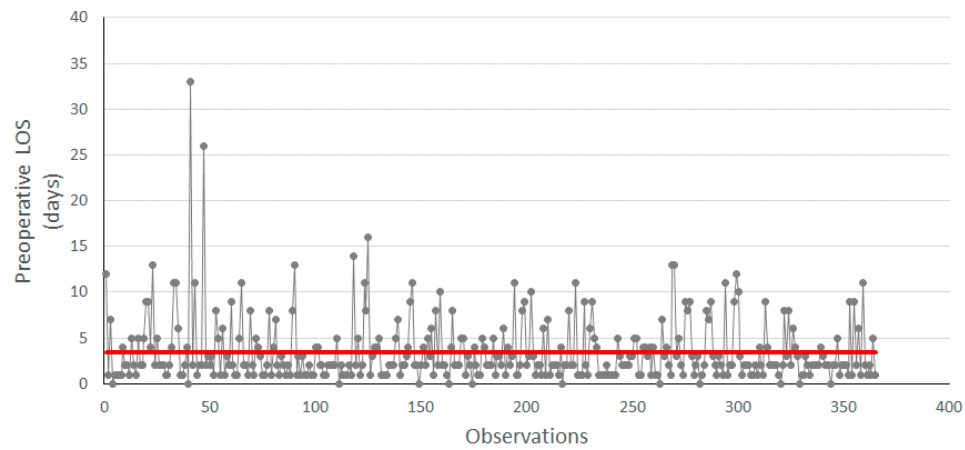
Figure 4. Run chart of preoperative LOS after improvement. Red line indicates the average value of 3.5.